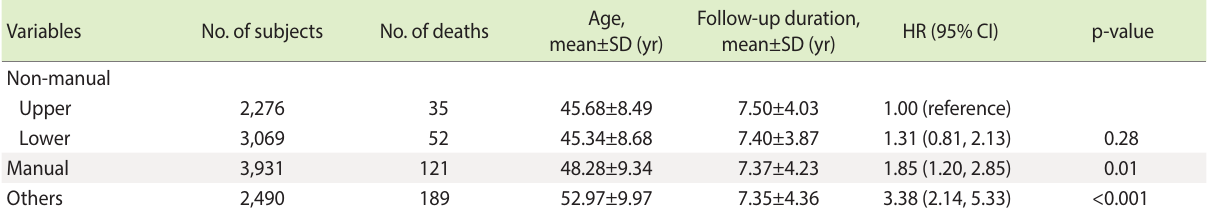
Table 1. Numbers of subjects and deaths, mean age, mean follow-up duration, and age-adjusted HRs and their 95% CIs for all-cause mortal- ity 1 by occupational class in Korean males aged 35 to 64 (n=11,766)